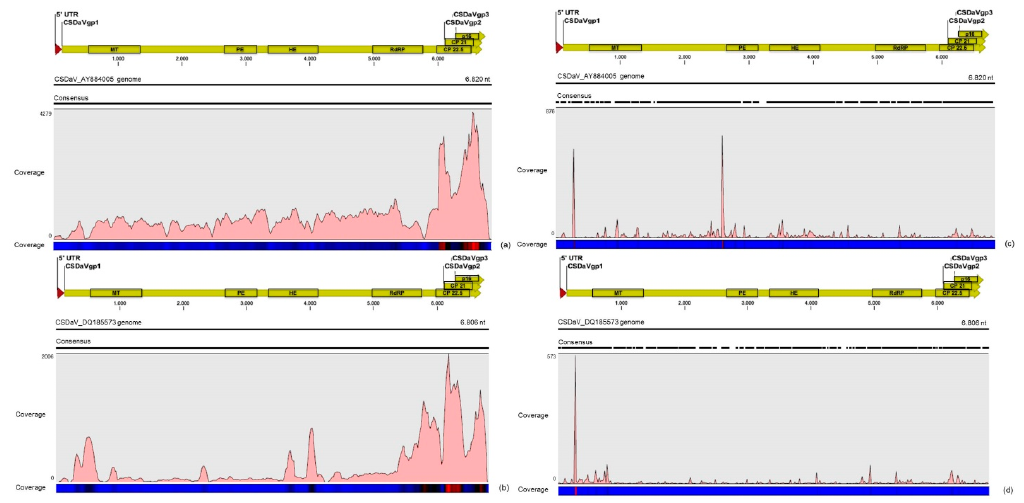
Figure 2. Profile distribution of reads from the RNA ‐ seq ( a , b ) and sRNA ( c , d ) libraries along the two Citrus sudden death ‐ associated virus (CSDaV) isolates under accession numbers: AY884005 ( a , c ); and DQ185573 ( b , d ). Genome organization of the CSDaV references is shown above the respective graphic. Color scale varies from 0 (light blue color) to 100% (red color) of coverage. graphic. Color scale varies from 0 (light blue color) to 100% (red color) of